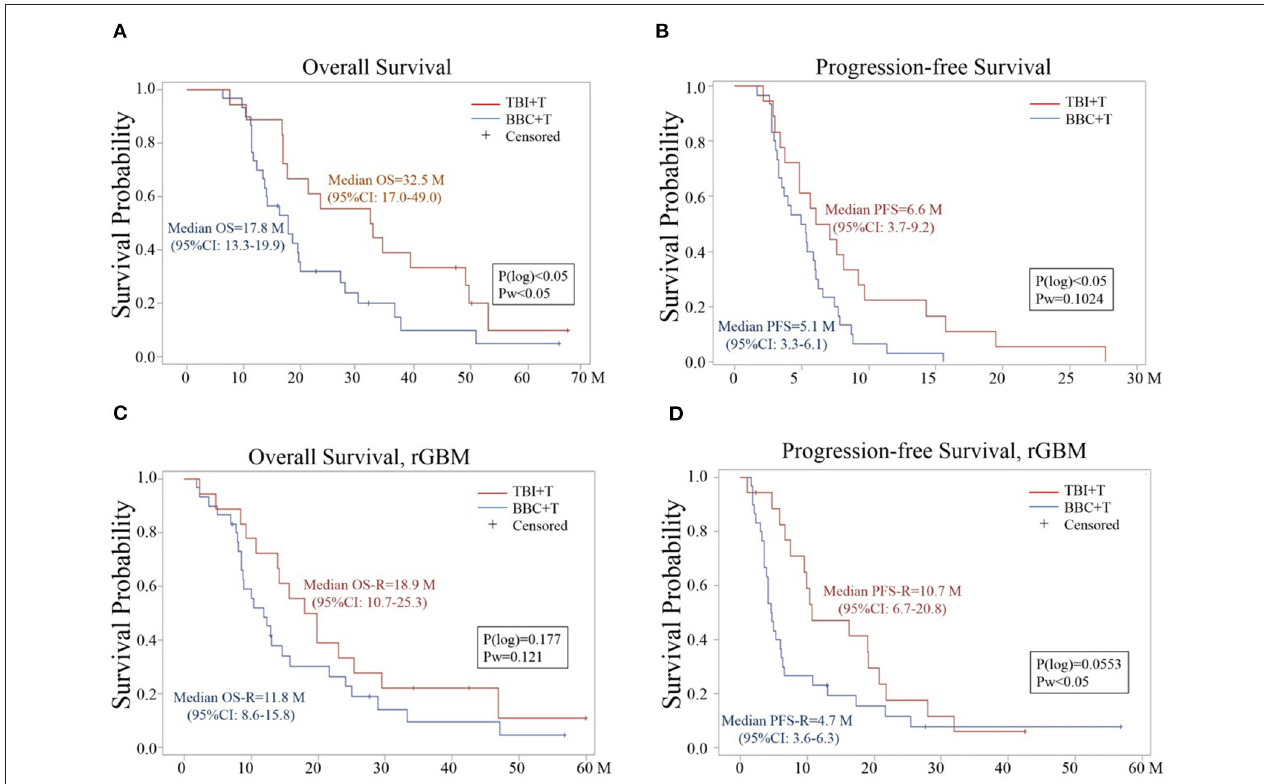
FIGURE 2 | Kaplan –Meier Estimator analysis of (A) OS, (B) PFS, (C) OS-R, and (D) PFS-R for TBI + T and BBC + T groups. P(log) is a p- value based on log-rank test; Pw is a p -value based on Wilcoxon test. 95%CI: 95% confidence interval.